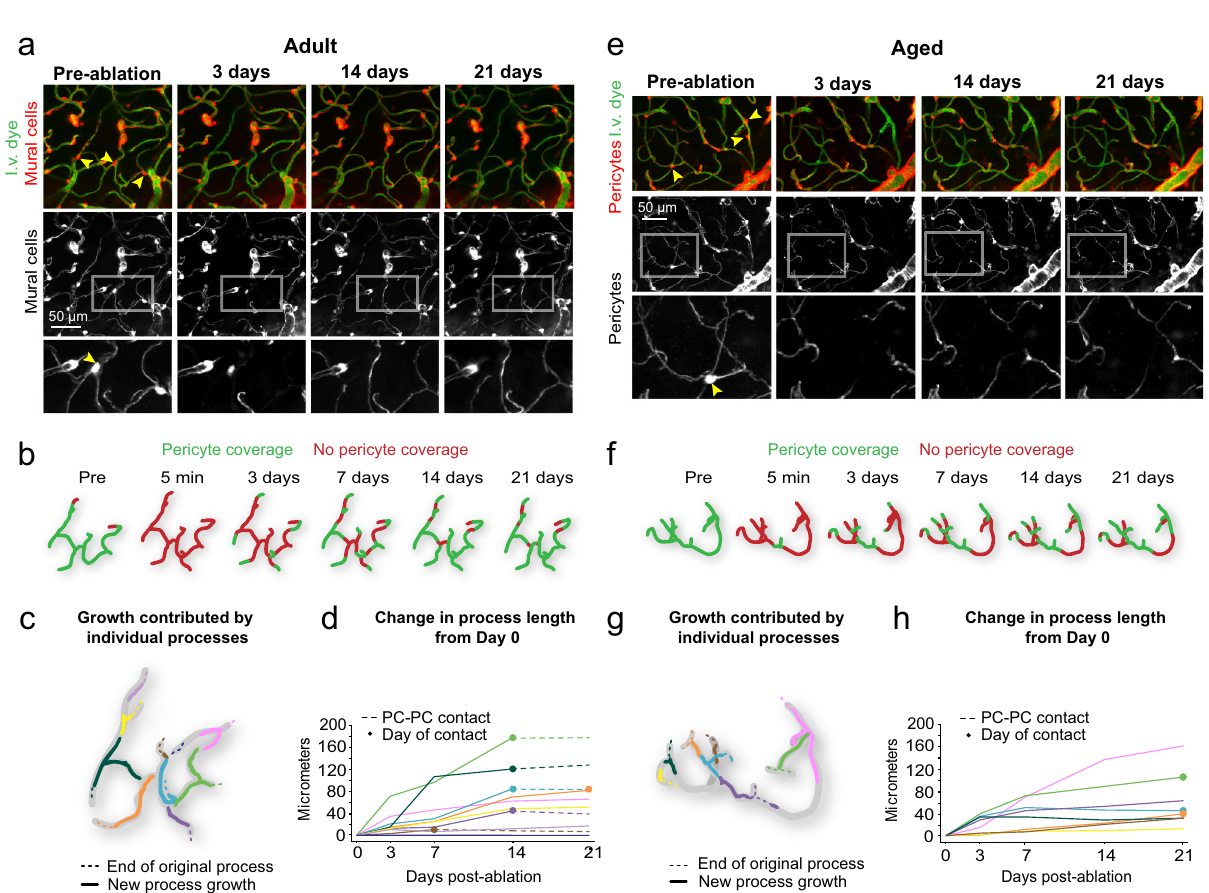
Fig. 2 | Pericyteremodeling ensurescapillary coverage followingpericyte loss. a Representative example of pericyte remodeling from an adult mouse (4 months old at pre-ablation), showing the area before triple pericyte ablation, and at select time-pointsafterablation.Arrowheadsindicatepericytestargetedforablation.The lower panels show mural cells only. Insets show magni fi ed view of region with pericyte ablation followed with remodeling of neighboring pericyte processes. Each example is selected from 7 experiments in adult mice. I.v. dye = intravenous dye. b Schematic of capillary coverage by pericytes on each imaging day. c Schematic representation of growth contributed by different pericyte processes